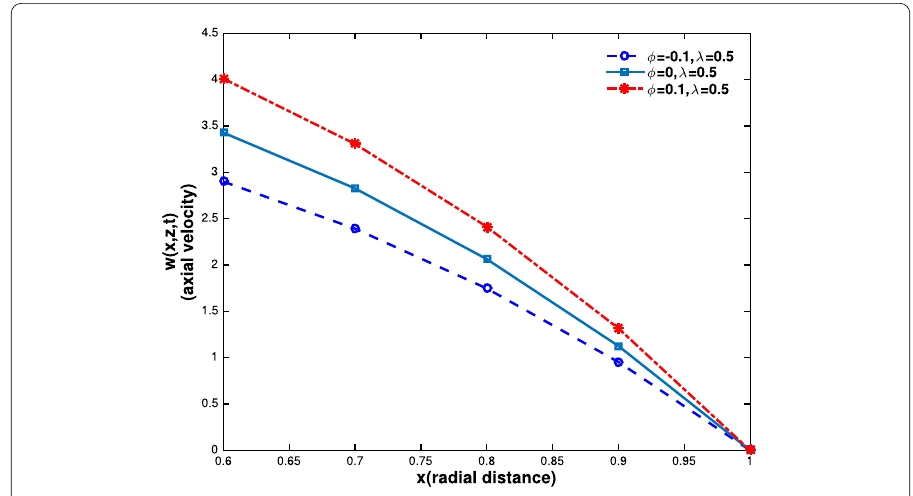
Figure 12 Axial velocity vs radial distances for φ = –0.1,0,0.1 at z = 28, t = 0.45, τ y = 0.4, K = 1.6, λ = 0.5